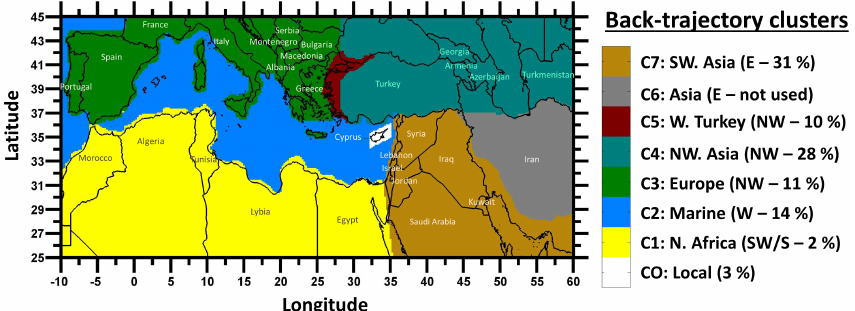
Figure 2. Classification of air masses which impacted the site during the intensive field campaign of March 2015 and their relative contribu- tion. A fraction of 2% (not shown here) is attributed to air masses of mixed